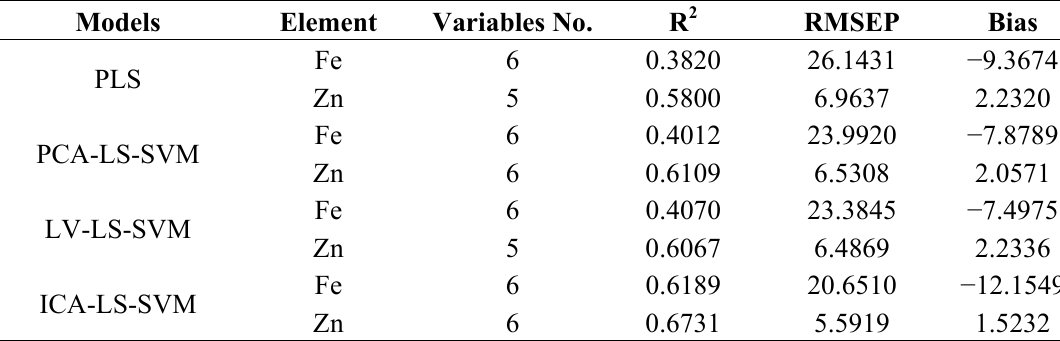
Table 2. The parameters of RMSEP and R 2 in the four